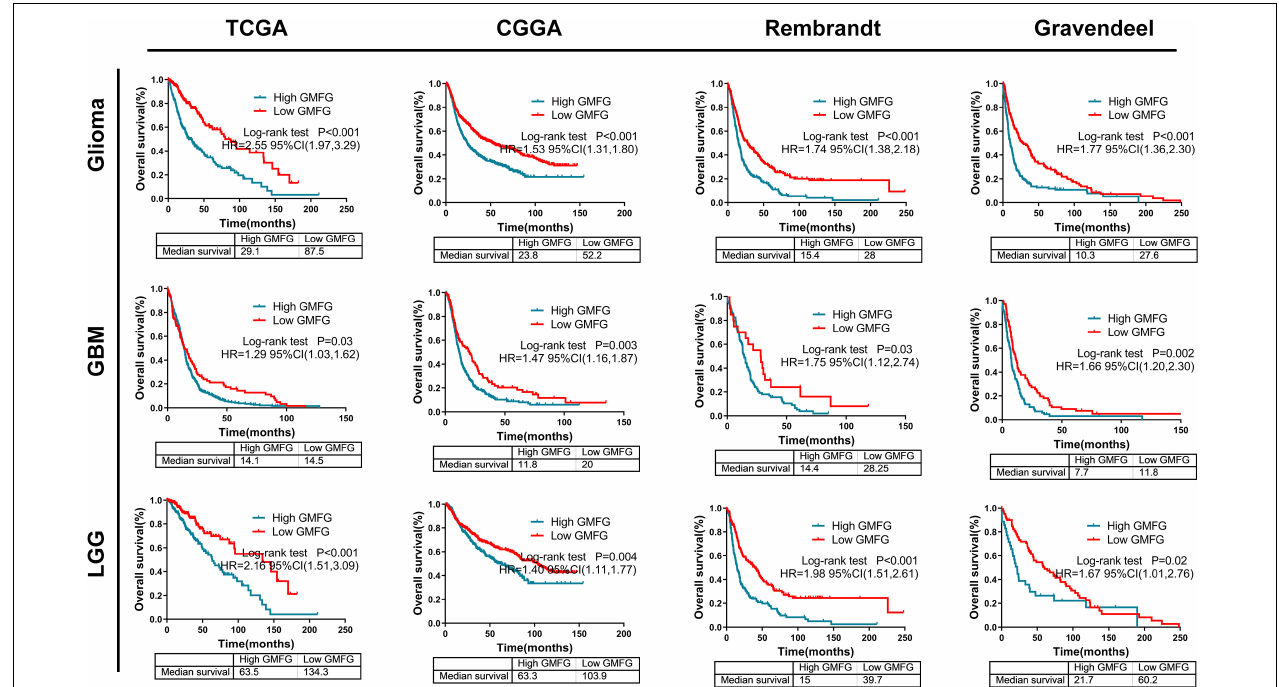
FIGURE 7 | High GMFG expression predicted a worse prognosis in gliomas. Kaplan–Meier curves were used to plot overall survival curves against optimal cutoff in TCGA, CGGA, Gravendeel, and Rembrandt datasets. The optimal cutoff was determined using GlioVis. HR, hazard ratio.